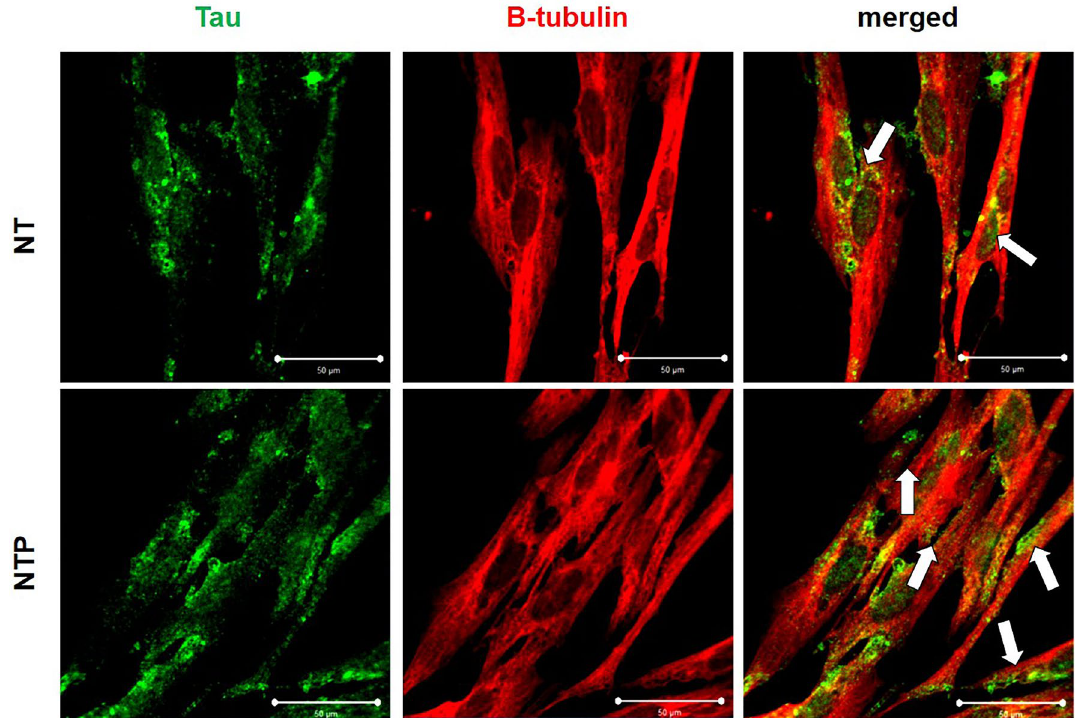
Figure 5. Immunofluorescence assay images. Tau and β-tubulin expression were detected with a confocal microscope. Tau was observed to be located around the nucleus in the NT group, while the expression of tau was increased around the axons in the NTP group (white arrow).* Scale bars = 50